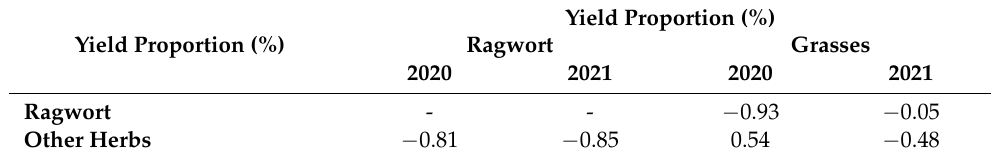
Table 5. Correlation matrix of yield proportions in ragwort, other herbs, and grasses. Yield Proportion (%) Yield Proportion (%) Ragwort Grasses Ragwort - - Other Herbs